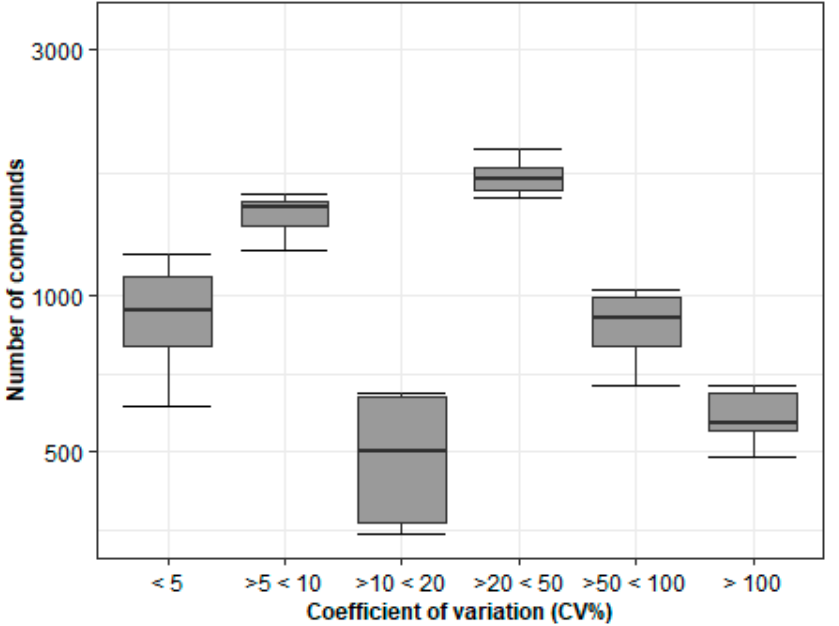
Figure 2. Inter-day influence (three days) of the storage conditions on the human blood metabolome. When DBS samples stored at room temperature were compared to DBS samples maintained at − 20 °C, majority of the compounds showed a CV ranging from 20% to 50%.